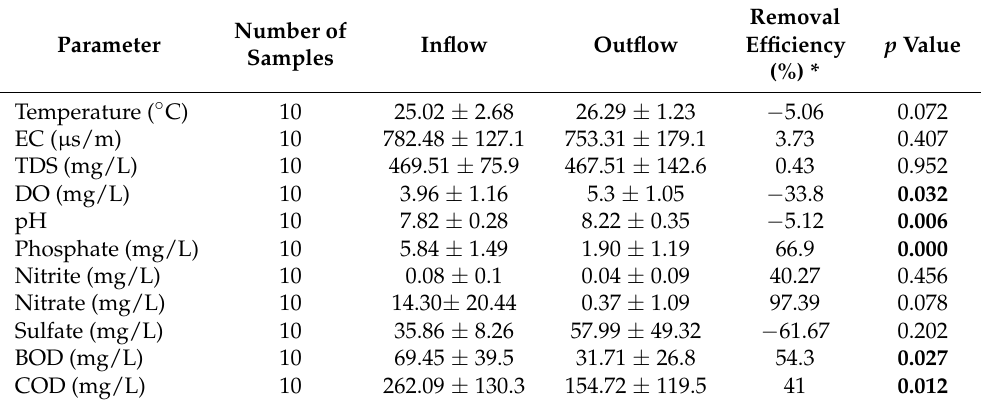
Table 3. Mean values of water quality parameters and variation percentages of the inflow and outflow of the constructed wetland of the Litani